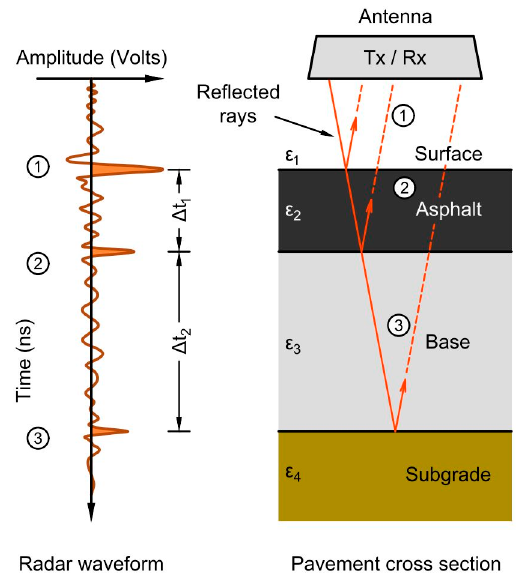
Figure 3. Radar pavement model [9].